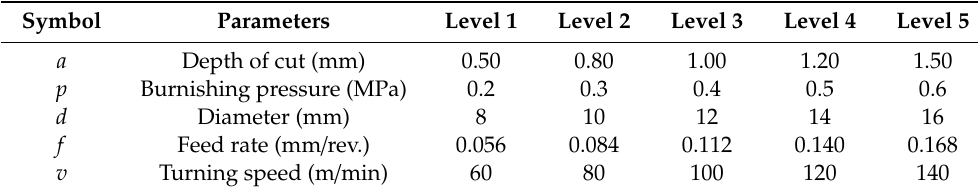
Table 2. Varied inputs.